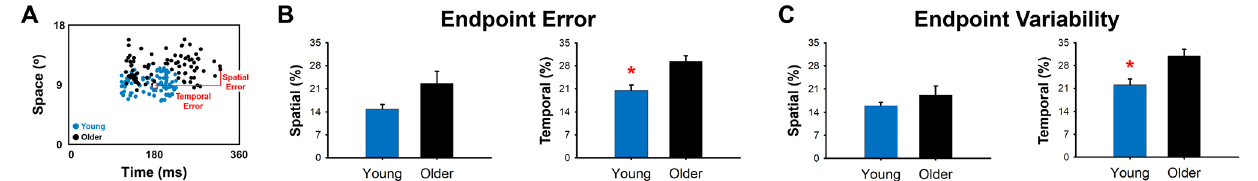
Figure 3. Age-associated differences in movement endpoint control. Representative example for a young and an older adult ( A ). On average, older adults exhibited similar spatial error but greater temporal error relative to young adults ( B ). Furthermore, older adults exhibited greater temporal variability but similar spatial variability ( C ). *p < 0.05.